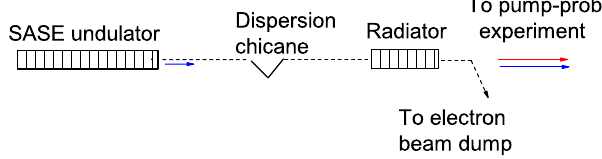
FIG. 1. (Color) Scheme of the afterburner for pump-probe ex- periments at an x-ray